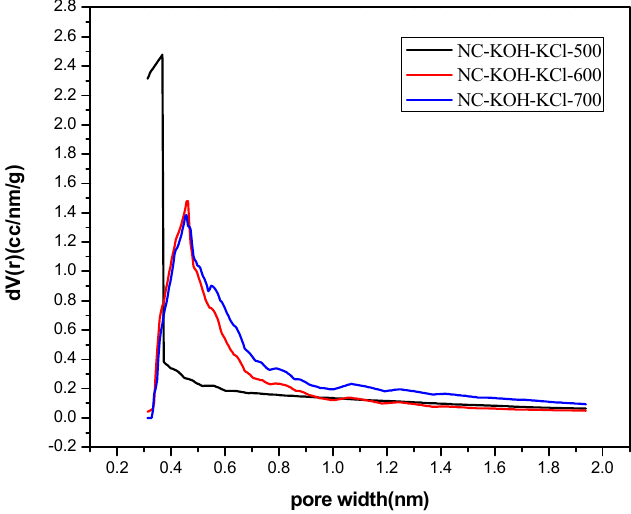
Figure 7. The micropore size distribution of samples carbonized at different temperatures.